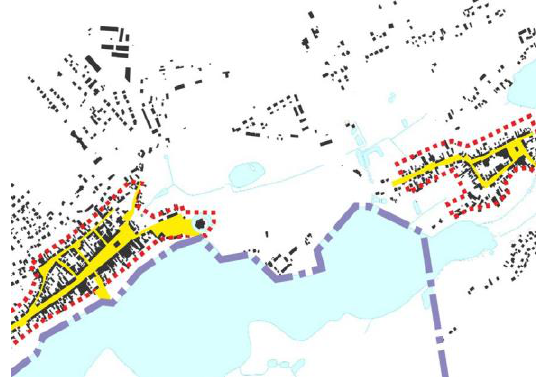
Fig. 1. Construction of historical parts of the city of Kórnik and its electric lighting within administrative boundaries [1, 2]